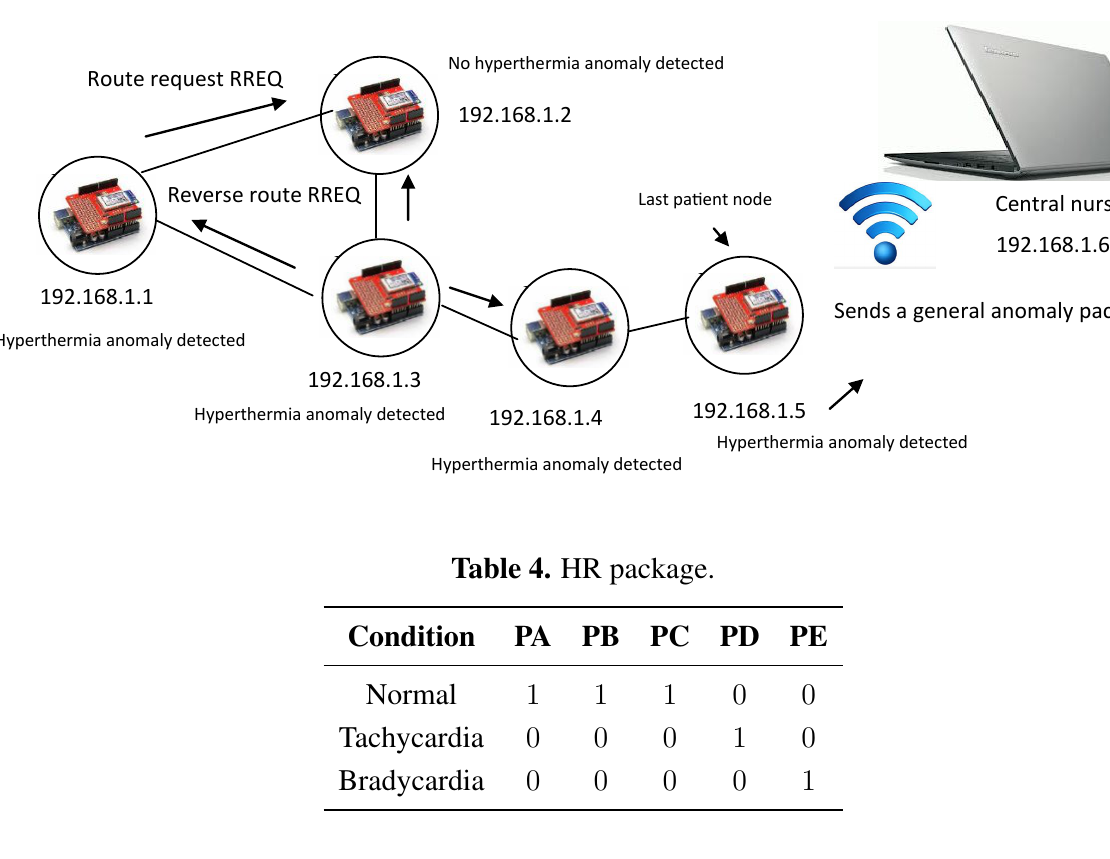
Figure 8. General anomaly detection via AODV routing.